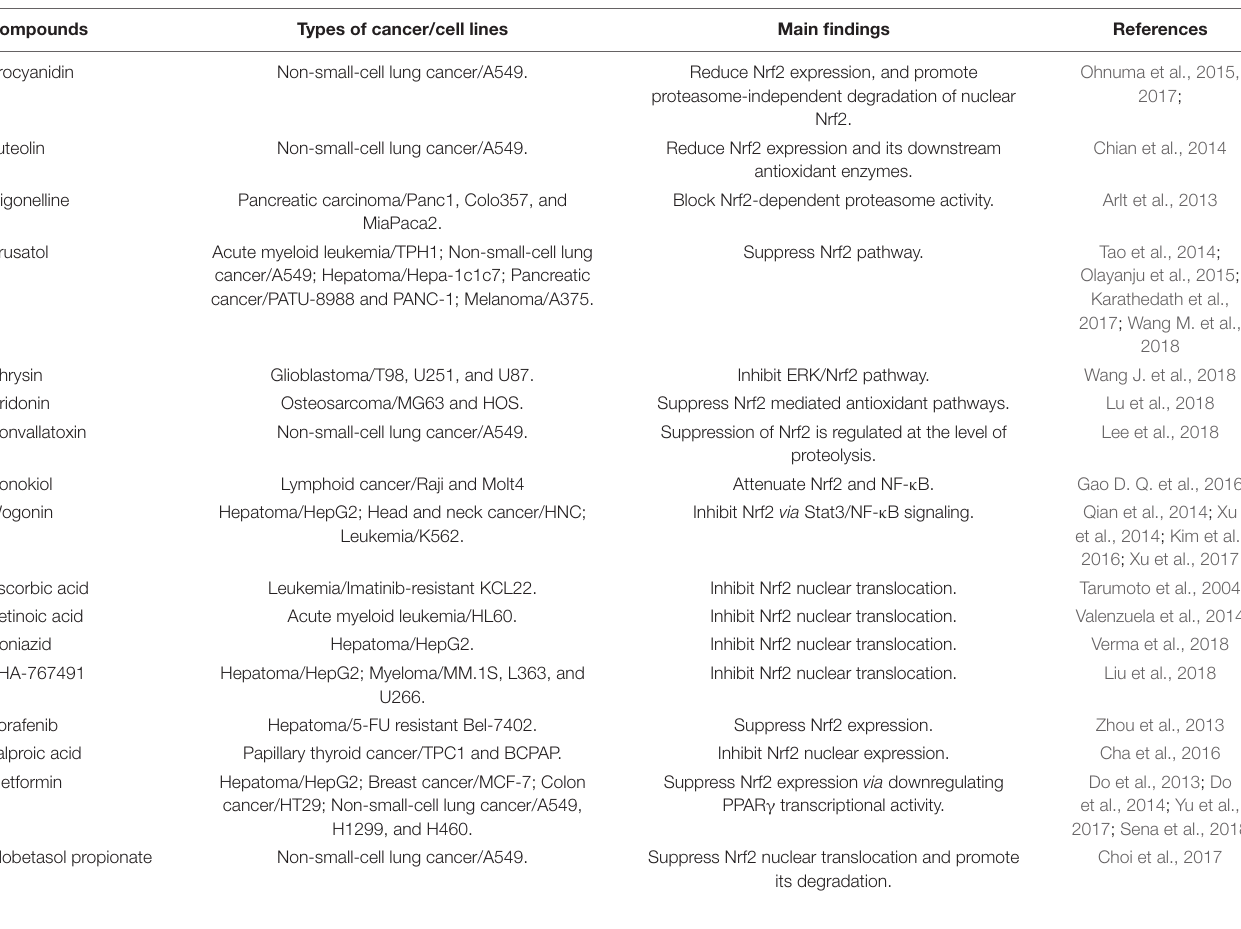
TABLE 1 | Nrf2 inhibitors in cancer